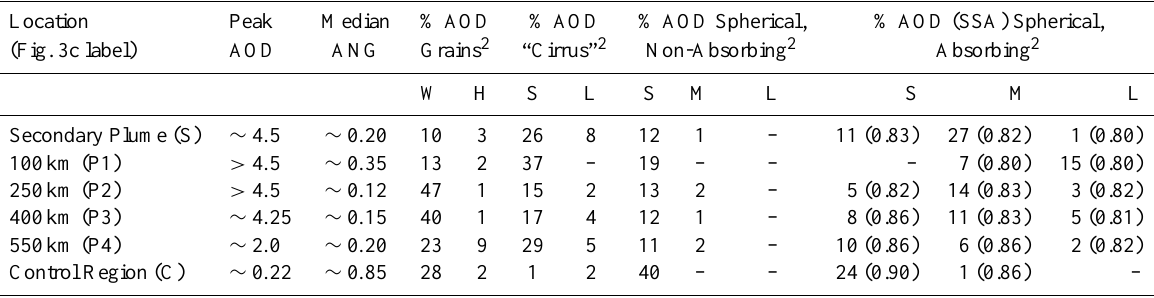
Table 3. Research Retrieval results overview for the 7 May 2010 plume. 1 See Fig. 3c for context. Location Peak Median % AOD % AOD % AOD Spherical, % AOD (SSA) Spherical, AOD ANG Grains 2 “Cirrus” 2 Non-Absorbing 2 Absorbing 2 W H S L S M L –